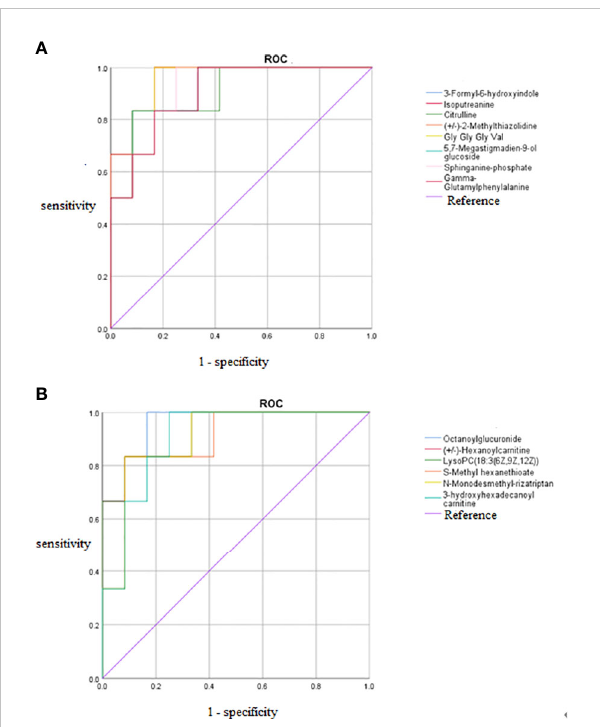
FIGURE 8 ROC curves of 14 potential biomarkers. (A) Increased potential biomarker ROC curves, (B) Decreased potential biomarker ROC curves. The AUC represents the area under the ROC curve and indicates the prediction accuracy. the AUC value takes on a value between 0 and 1, with larger values representing higher correctness rates. ROC, receiver operating characteristic curve; AUC, area under the